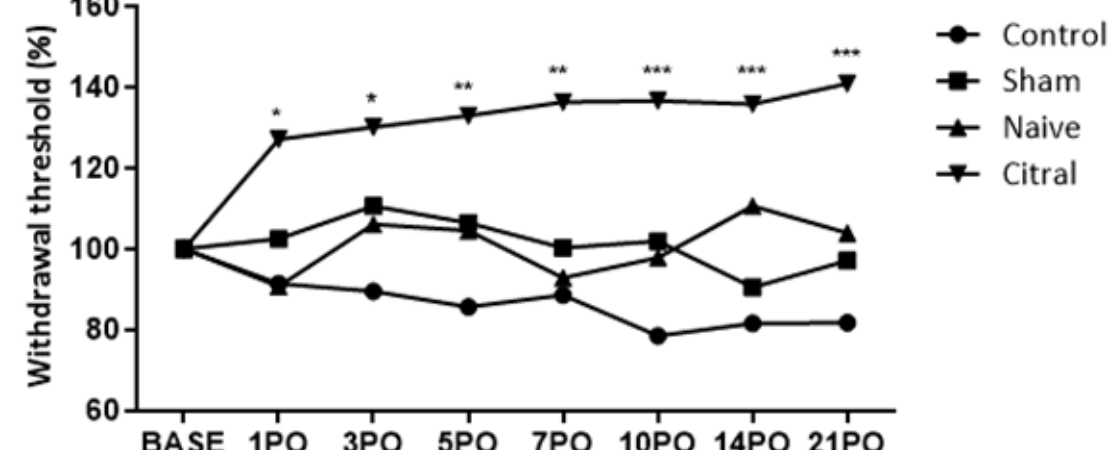
Figure 6: Time course of effect of citral (0.1 mg/Kg) on neuropathic nociception induced by infraorbital nerve transection in rats. PO = Postoperatively. Two-way ANOVA with post-hoc Bonferroni correction (*p<0.05, **p<0.01, ***p<0.001 vs control). Citral and vehicle (control) were administered by gavage. Data are expressed as the mean ± S.E.M. (n=6/group) and compared to control group. Control (BASE 0.000, 1PO 0.081, 3PO - 0.058, 5PO 0.046, 7PO 0.095, 10PO 0.036, 14PO 0.049, 21PO